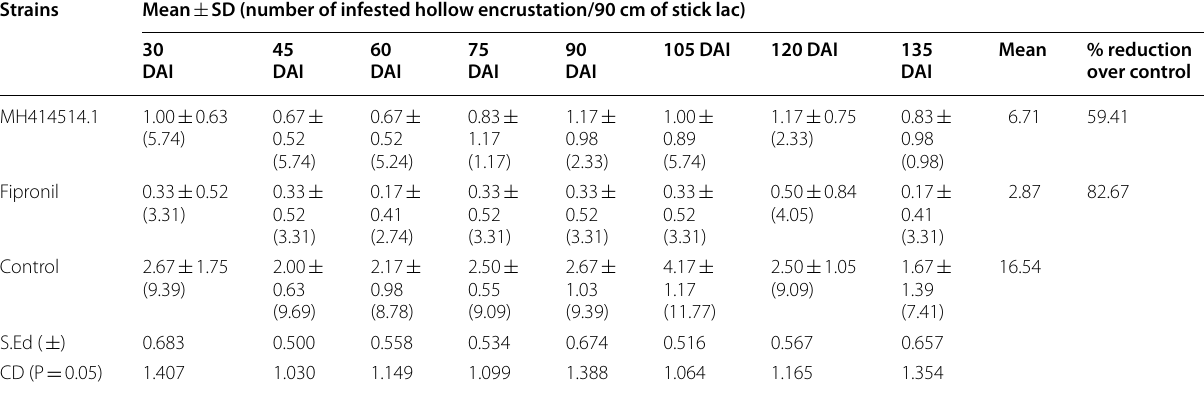
Data are mean of 7 replications. Data within the parentheses are angular transformed value DAI days after inoculation of broodlac